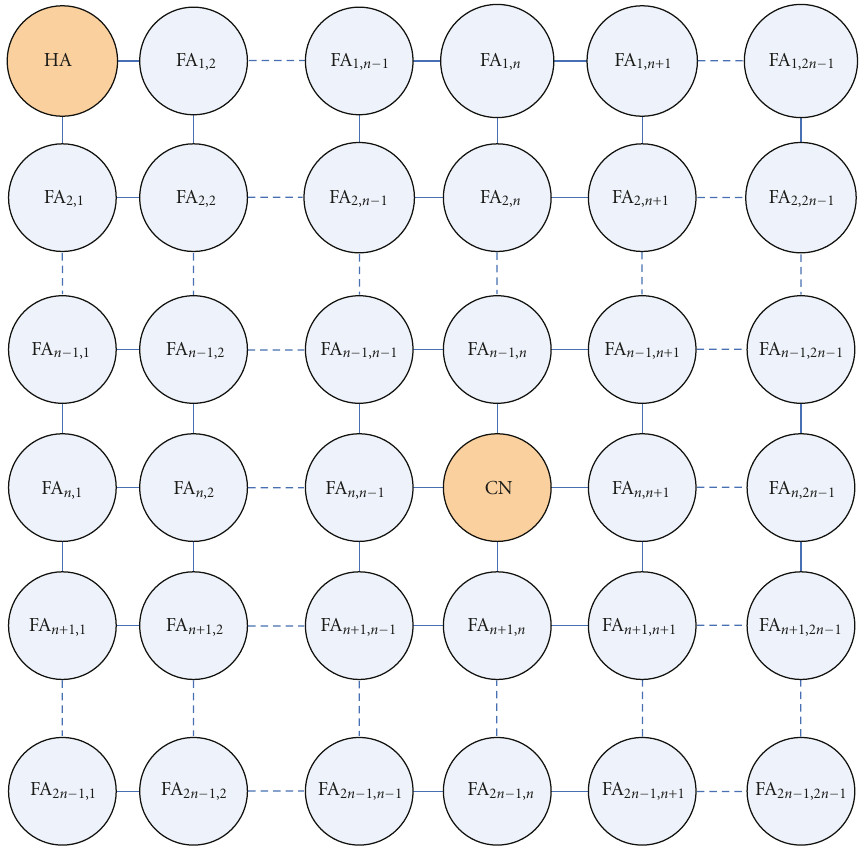
Figure 4: Network topology of the analytical